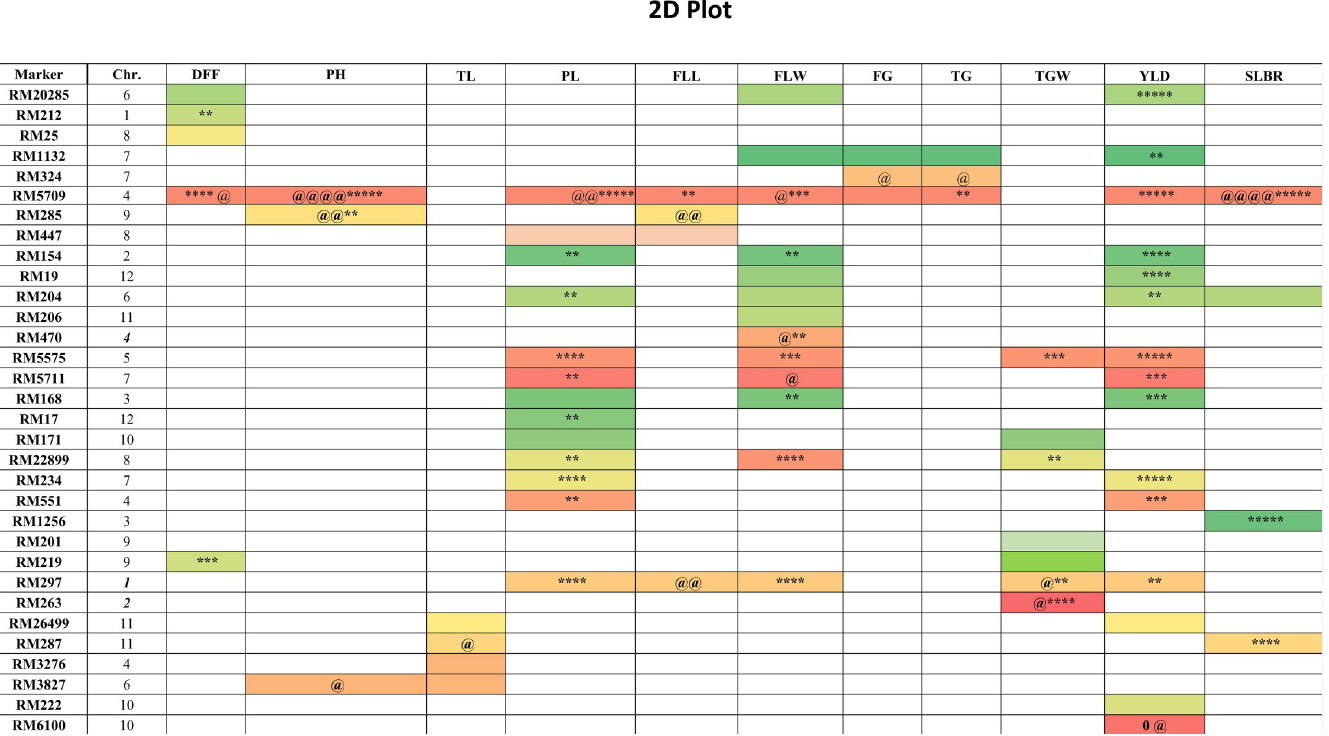
Fig 8. The 2D-Plot showing SSR marker association with respective phenotypic traits using GLM (p-0.005) and MLM (p-0.005) models. MLM = @ -Markers associated with MLM in the specific -season /environment ; �� / @@ = Indicates SSR markers associated in two seasons/ environments ; ��� / @@@ = Indicates SSR markers associated in three seasons/ environments ; ���� / @@@@ = Indicates SSR markers associated in four seasons/ environments .